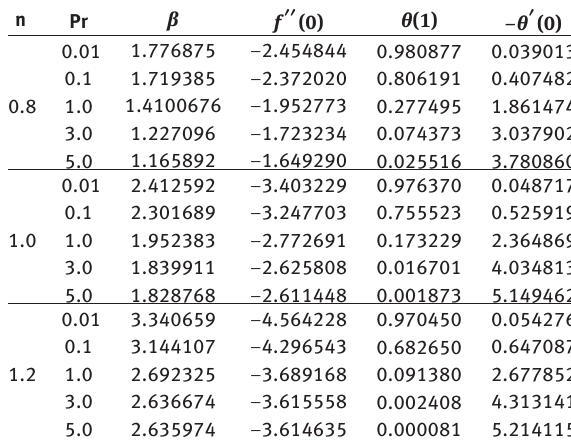
(cid:2) (0) for different values